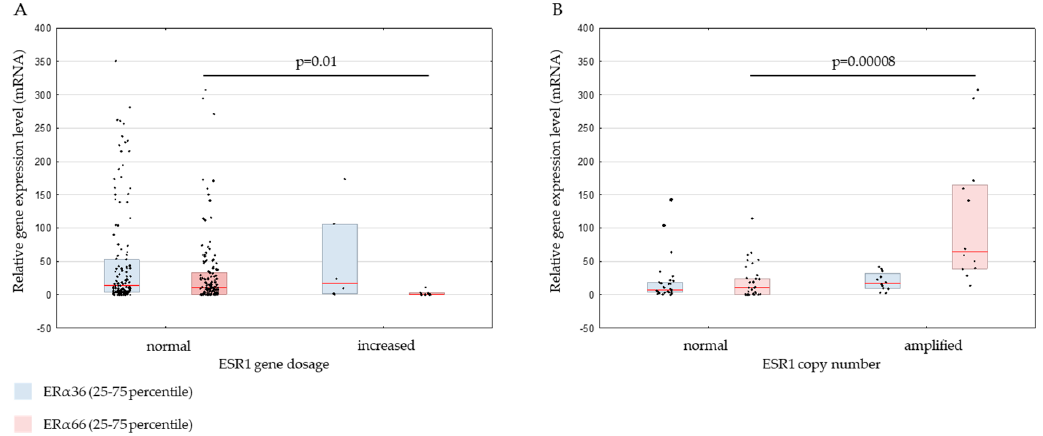
Figure 3. ER α 36 and ER α 66 relative gene expression levels in primary breast cancers classified according to ESR1 gene dosage status measured by qPCR ( A ) or ESR1 gene copy number measured by FISH ( B ). The vertical red line represents the median gene expression level. * p < 0.05, ** p < 0.0001. ER α : estrogen receptor alpha.